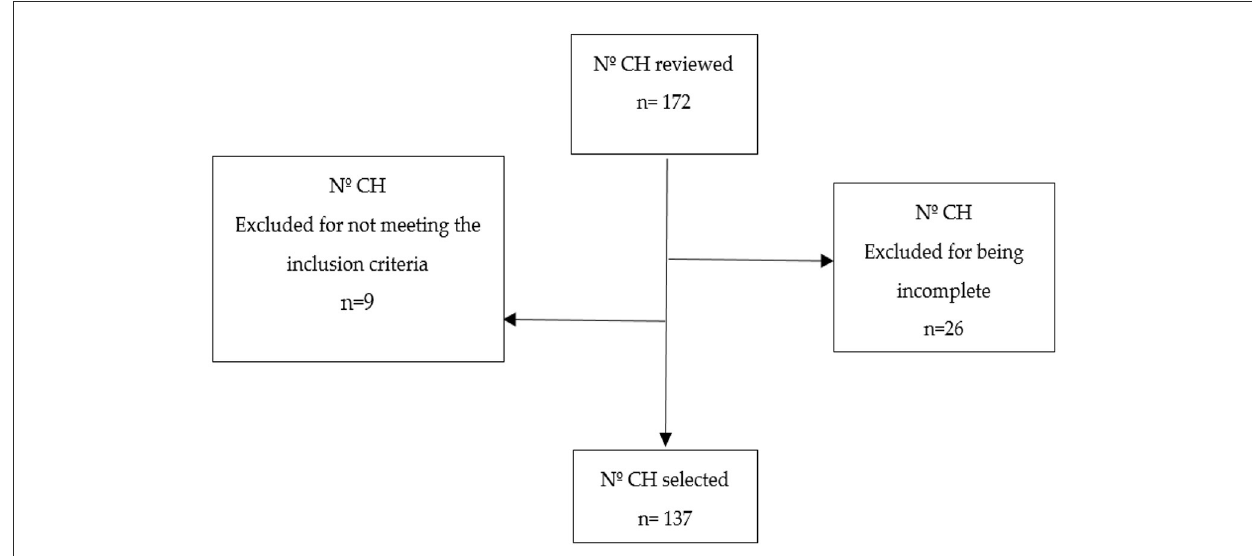
FIGURE1 Sample selection process. CH, clinical